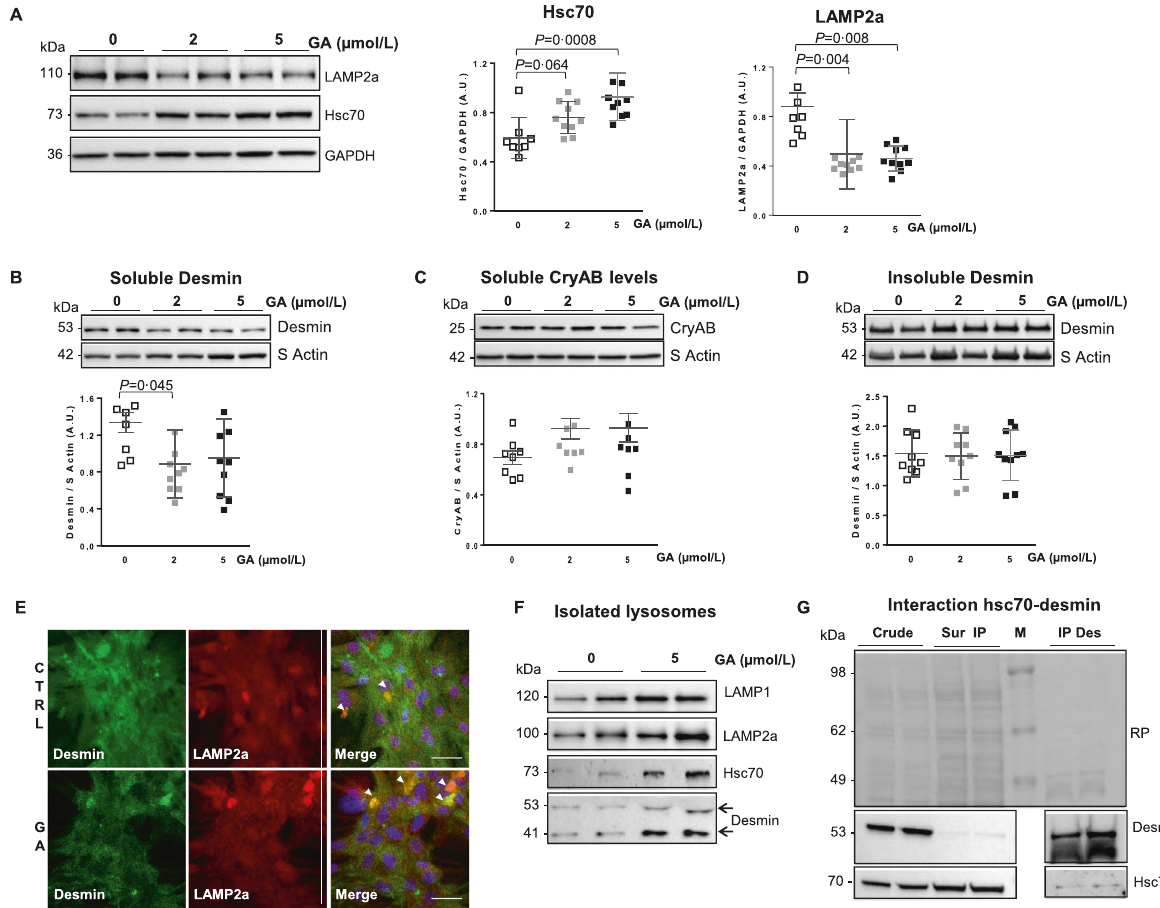
Fig. 4 Clearance of soluble desmin by inducing CMA in vitro in cardiomyocytes. A Representative western blots and quanti fi cation of CMA markers: Hsc70 (left panel) and LAMP2a (right panel) in control ( n = 8) and NCM treated with 2 and 5 µmol/L of geldanamycin (GA) during 17 h ( n = 10). B , C The impact of CMA induction was evaluated by western blot on soluble protein fractions in the same samples for desmin ( B ) and CryAB ( C ). D The impact of CMA induction on insoluble desmin was evaluated by western blot in the same samples. The loading controls (GAPDH and S Actin) are indicated on the graphs. Graphs show mean ± SEM values expressed in arbitrary units (A.U.). Signi fi cant P values are indicated on the graphs. E Representative immuno fl uorescence staining of desmin (green) and LAMP2a (red) in control and NCM treated with 5 µmol/L of GA during 17 h. Nuclei are stained in blue. Arrows show the colocalization points. Scale bar represents 30 µm. F Representative western blots of lysosome marker (LAMP1), CMA markers (LAMP2a and Hsc70), and desmin in isolated lysosomes of H9c2 cells treated or not with 5 µmol/L of GA during 17 h. Arrows show the different desmin entities. G Detection of interaction between desmin and Hsc70 in H9c2 cells by immunoprecipitation of desmin followed by western blot for desmin and Hsc70. Crude: crude cells sample; Sur IP: supernatant of desmin immunoprecipitation. IP Des: immunoprecipitation of desmin; Ef fi ciency of Des IP was veri fi ed with desmin western blot; M: size markers are indicated on the left side of red ponceau (RP) staining membrane. (Fig. 4G), showing the ability of Hsc70 to target desmin to the lysosomes. We also checked the speci fi city of CMA activation in cardiomyocytes by analyzing the impact of GA on other protein degradation pathways. We found no modulation of the ubiquitin-proteasome pathway (Fig. S6A), but a signi fi cant decrease of macroautophagy markers in cardiomyocyte (Fig. S6B). Then, we used a combined pharmacological treatment with MG132, a proteasome inhibitor, and 3-methyladenine (3MA), a macroautophagy inhibitor. We veri fi ed that the co- treatment induced speci fi cally CMA activation by the signi fi - cantly increased Hsc70 levels as previously shown (Fig. 5A) and signi fi cant inhibition of macroautophagy assessed by LC3II/LC3I ratio (Fig. 5A), and LC3II, with no modulation of Beclin-1 and p62 levels (Fig. S6C). As expected, the inhibition of proteasome induced signi fi cantly increased levels of ubiquitinated proteins exacerbated upon inhibition of macroautophagy (Fig. 5B). With this other pharmacological treatment, we observed a signi fi cant